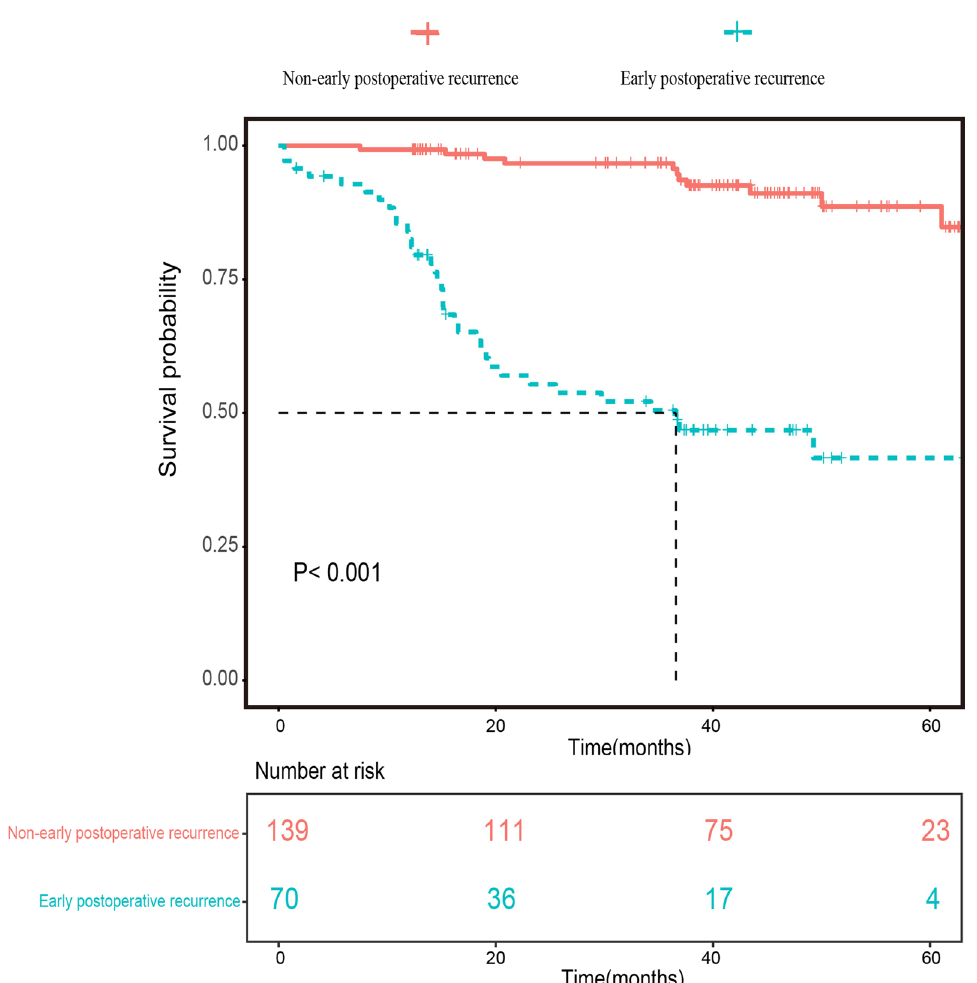
Fig. 2 Kaplan–Meier curves of patients’ overall survival according to patients with and without Early postoperative